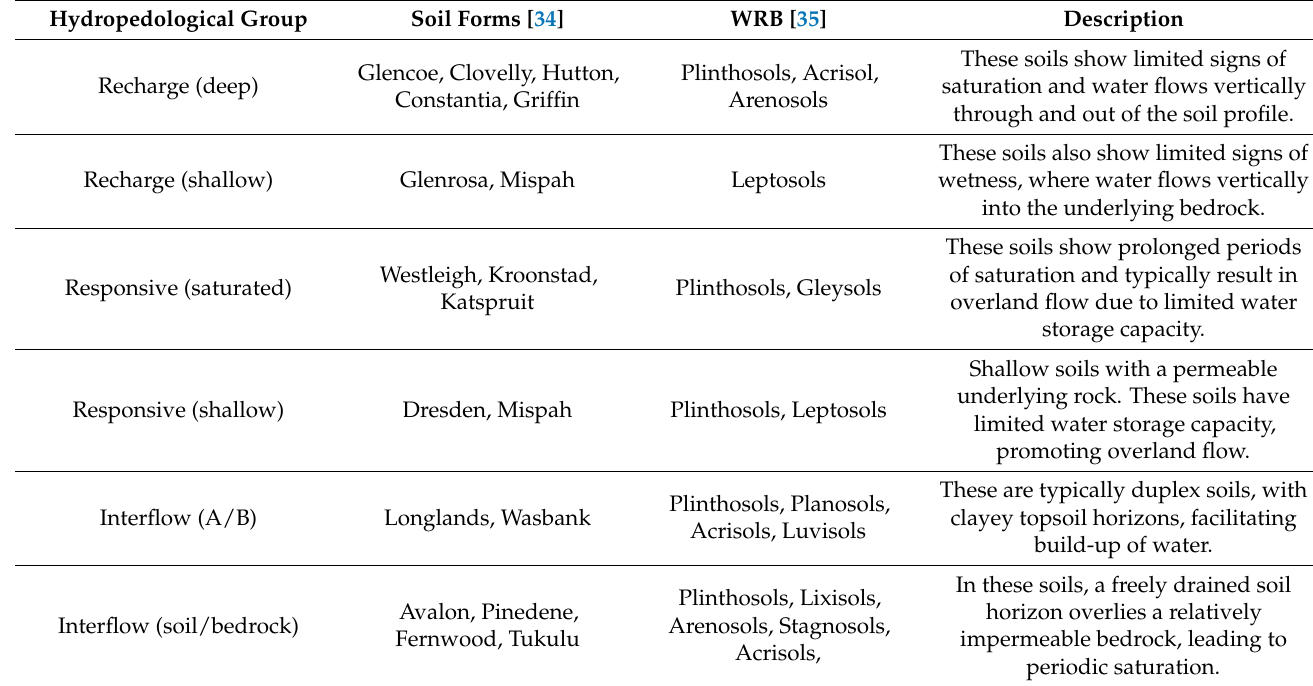
Table 1. Description of the six hydropedological groups and the respective South African and FAO WRB soil classifica- tion systems.